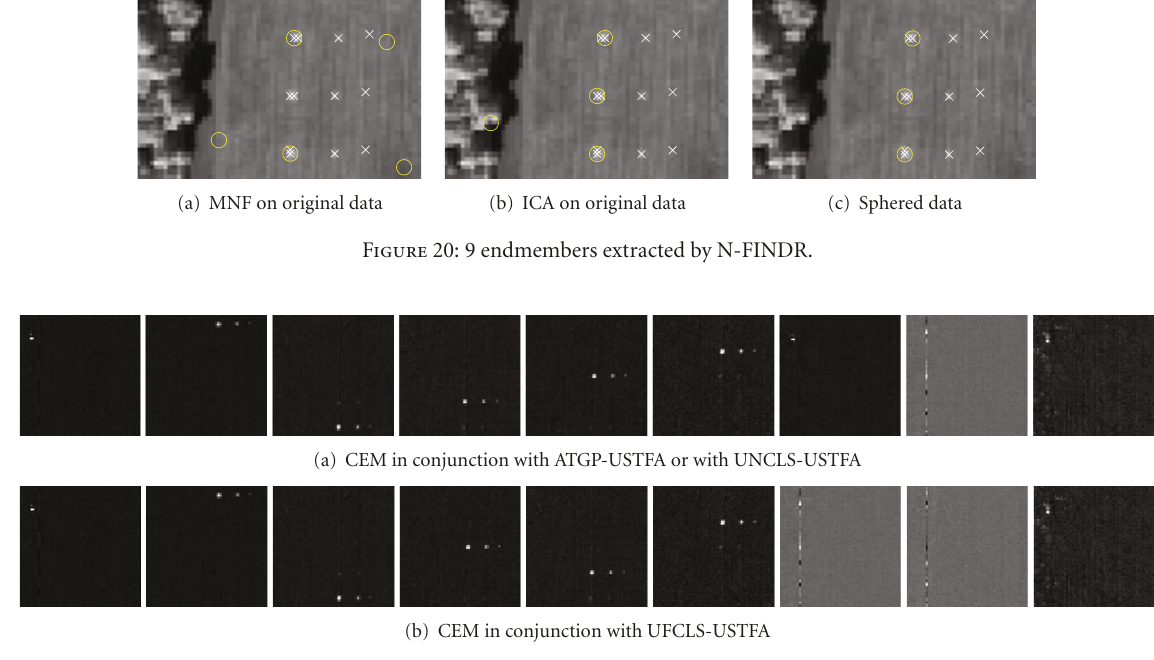
Figure 21: CEM detection results using the 9 targets of interest generated by the ATGP, UNCLS, and UFCLS in Figures 16(b), 17(b), and 18(b).